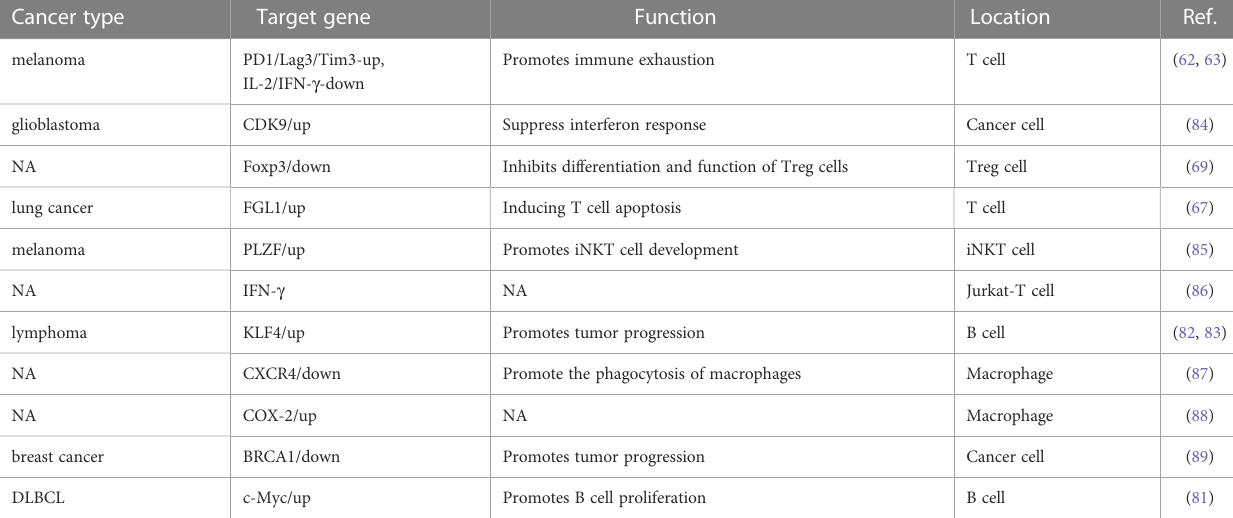
TABLE 3 The mechanism of YY1 in the tumor immune